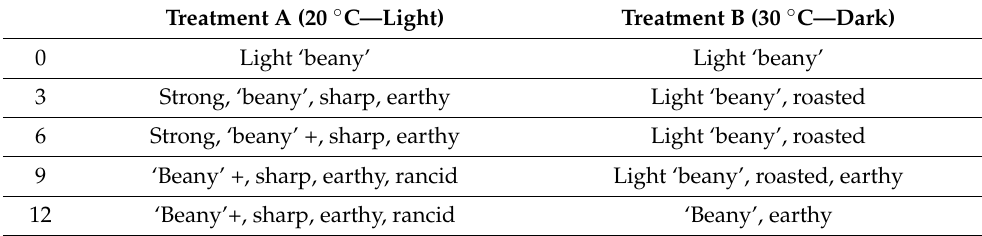
Table 2. Odor evolution during the ageing (evaluation by three